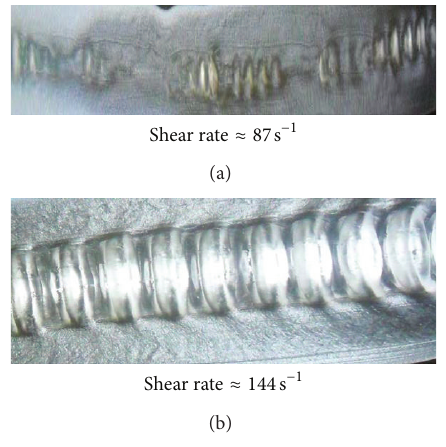
Figure 9: HDPE extrudate at a shear rate of 87 s −1 (stick-slip region) and (b) at a shear rate of 144s −1 (gross-melt fracture region).